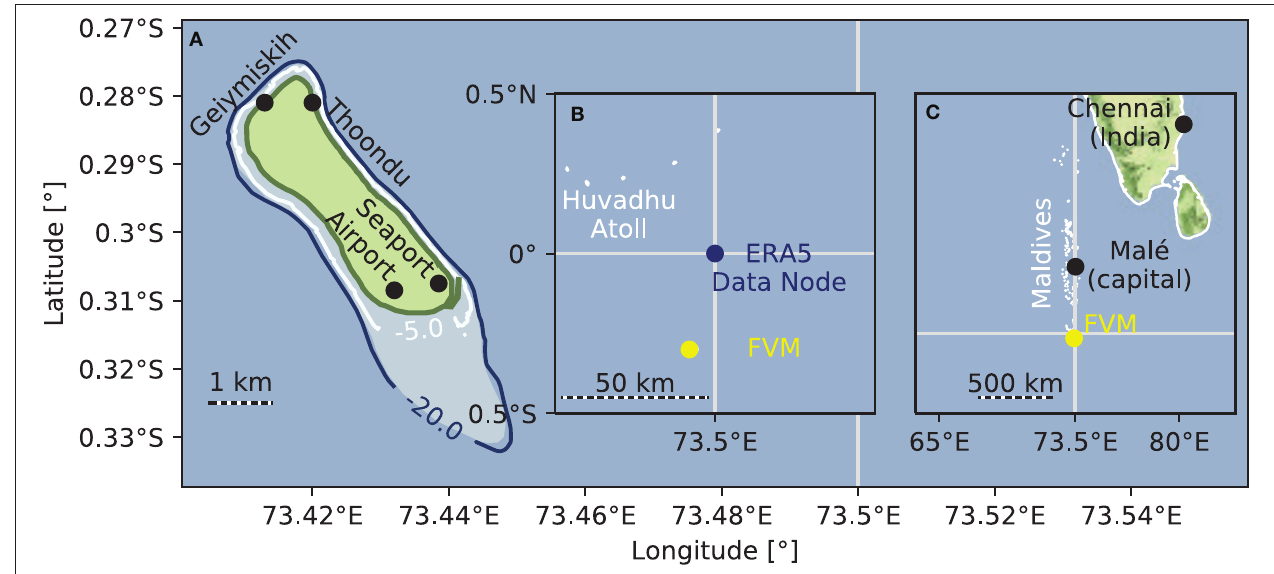
FIGURE 1 | Location of FVM. (A) Shows the extent of the island and the fringing reef. It also illustrates the position of the air- and seaport, as well as the beach of Thoondu and the coastal spit. The bathymetry lines come from echo-sound measurements of the first field survey (March 2017). (B) Shows the location of Fuvahmulah in the Indian Ocean. The data node is the virtual wave gauge at 0 ◦ latitude and 73.5 ◦ longitude. In this study, the virtual wave gauge provides information on the wave climate, based on the ERA5 data assimilation of hourly single levels from 1979 to near present (C3S, 2017, see Figure 2 ). (C) Shows the island location within the Maldives, Indian Ocean and the location referred to south India and Sri Lanka. Plots were generated with Matplotlib version 3.1.1 (RRID:SCR_008624) and Cartopy. Cartopy also delivered the coastlines in (B,C)